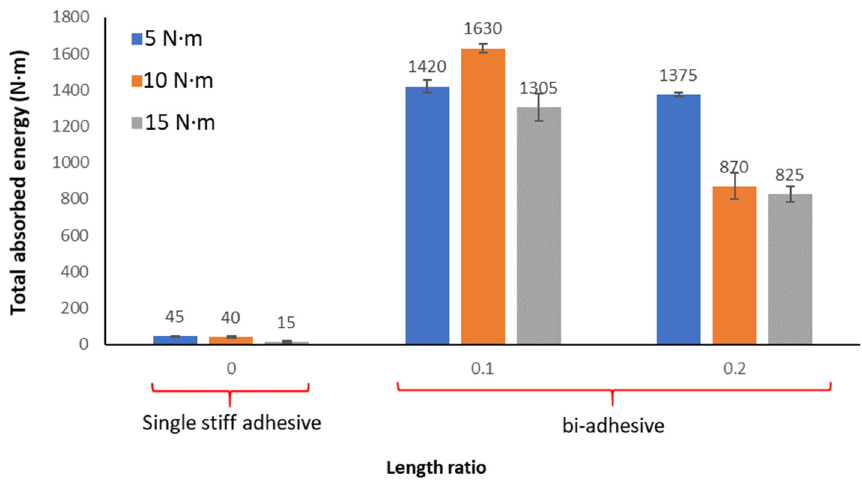
Figure 8. Total energy absorption of single- and bi-adhesive CFRP/steel joints subjected to different impact energy levels.